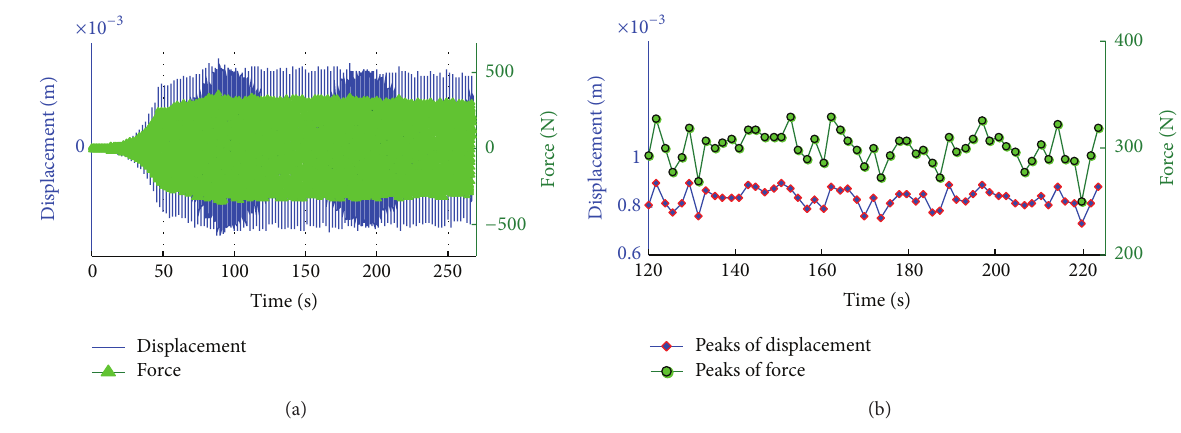
Figure 11: Time history of excitation test and selection of amplitude range. Table 3: A comparison between the calculated and measured dynamic